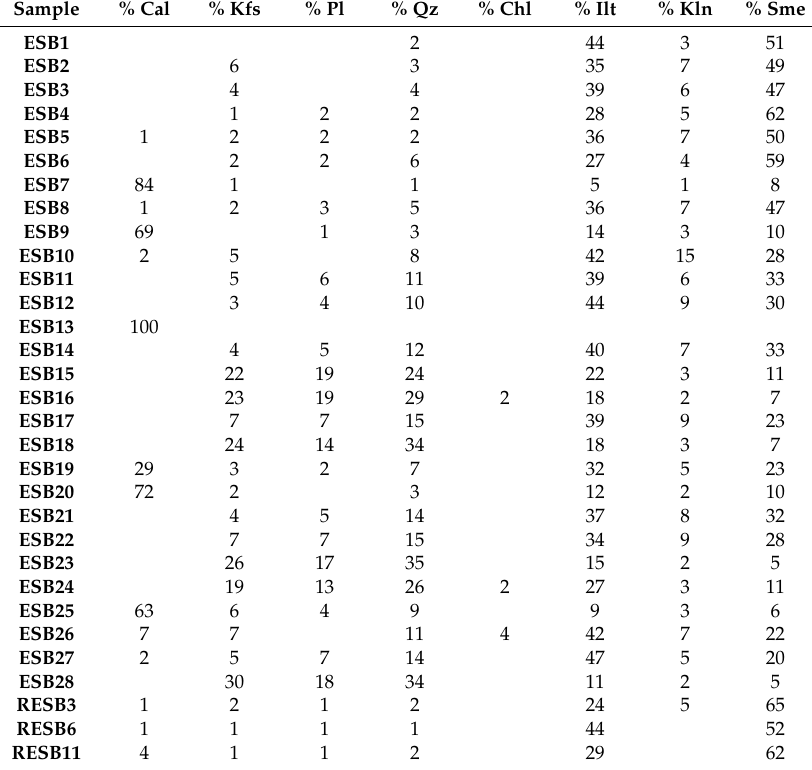
Table 1. Semi-quantification of the mineral content of the samples from X-ray diffraction (XRD). Calcite (Cal), chlorite (Chl), illite (Ilt), kaolinite (Kln), plagioclase (Pl), potassium feldspar (Kfs), smectite (Sme) and quartz